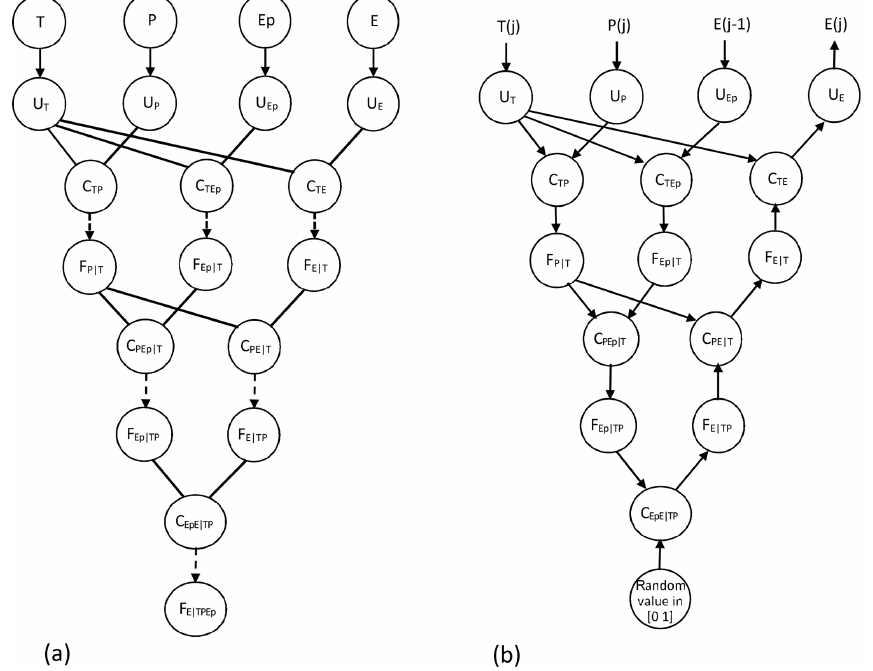
Figure 3. Construction of C-vine copula V TPE